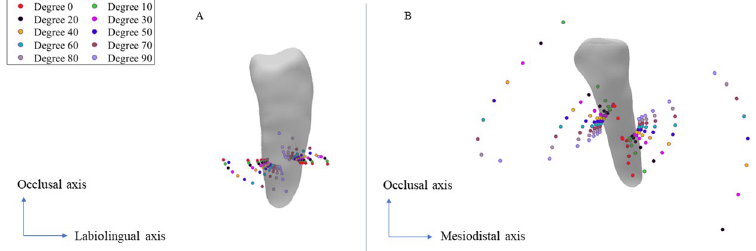
Fig 6. The influence of the force direction on the position of the CRots in scenario 3. The force and moments are applied directly to the CRes of the left premolar of Patient 1 . A: The CRots of the forces rotating from long axis towards the labiolingual direction of the tooth. B: The CRots of the forces rotating from the mesiodistal axis towards the long axis of the tooth. Note that each color corresponds to a different force direction, the M : F changes from -12N to 12N, and the distance between the CRots of the same color changes nonlinearly while the M : F values increment linearly.